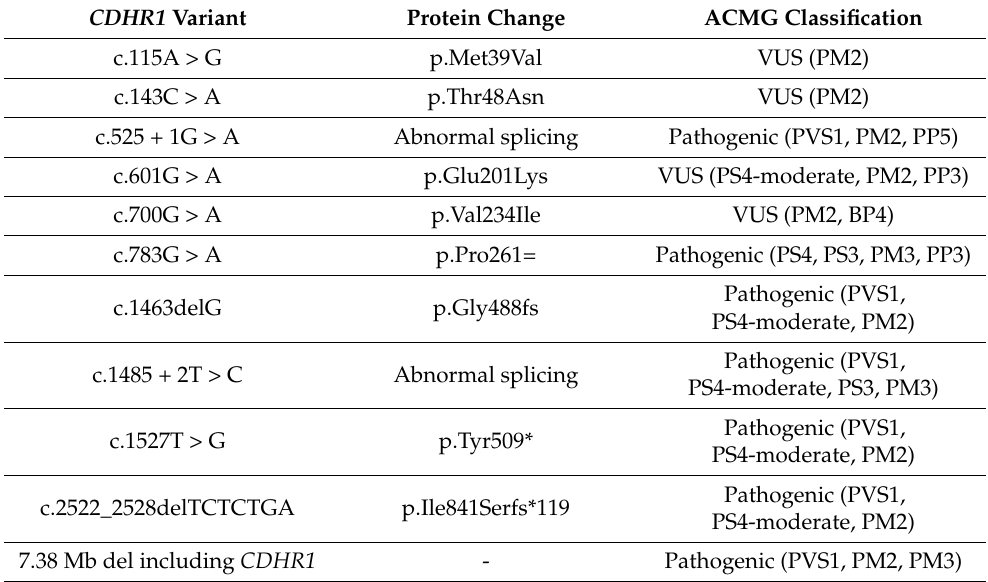
Table 1. Summary of all CDHR1 variants identified in this study according to ACMG standards